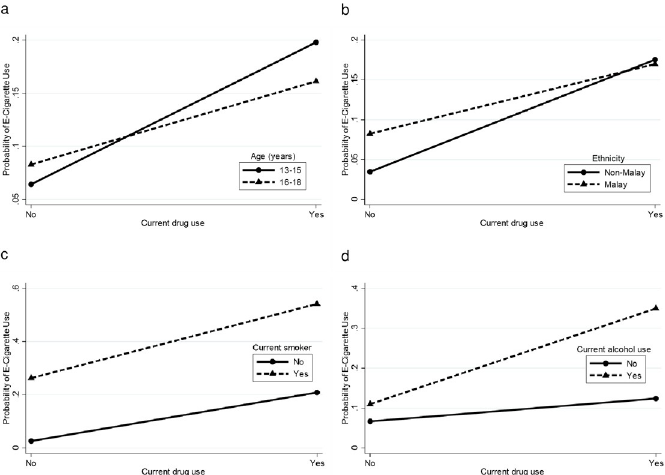
Fig 5. Probability of current e-cigarette use. (a) Current drug use-age: no (13–15 = 6.4%, 16–18 = 8.3%), yes (13– 15 = 19.8%, 16–18 = 16.1%). (b) Current drug use-ethnicity: no (non-Malay = 3.5%, Malay = 8.2%), yes (non- Malay = 17.6%, Malay = 17.0%). (c) Current drug use-current smoker: no (yes = 26.3%, no = 2.6%), yes (yes = 54.2%, no = 20.9%). (d) Current drug use-current alcohol use: no (yes = 11.0%, no = 6.7%), yes (yes = 35.0%, no = 12.4%).